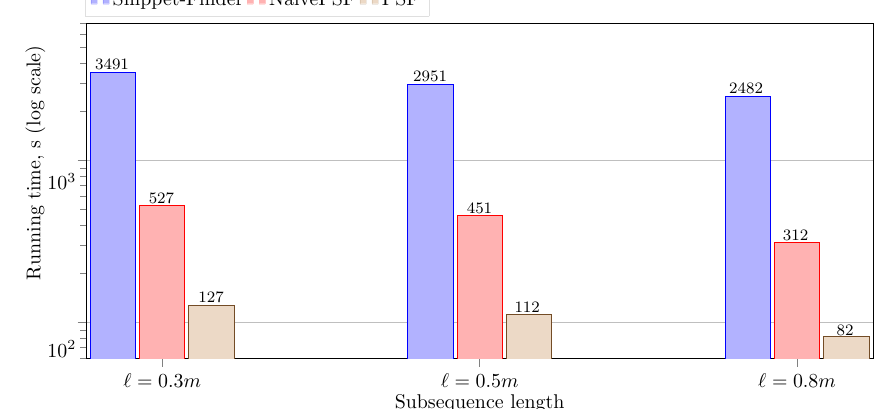
Figure 8. Performance of the PSF algorithm depending on the segment length